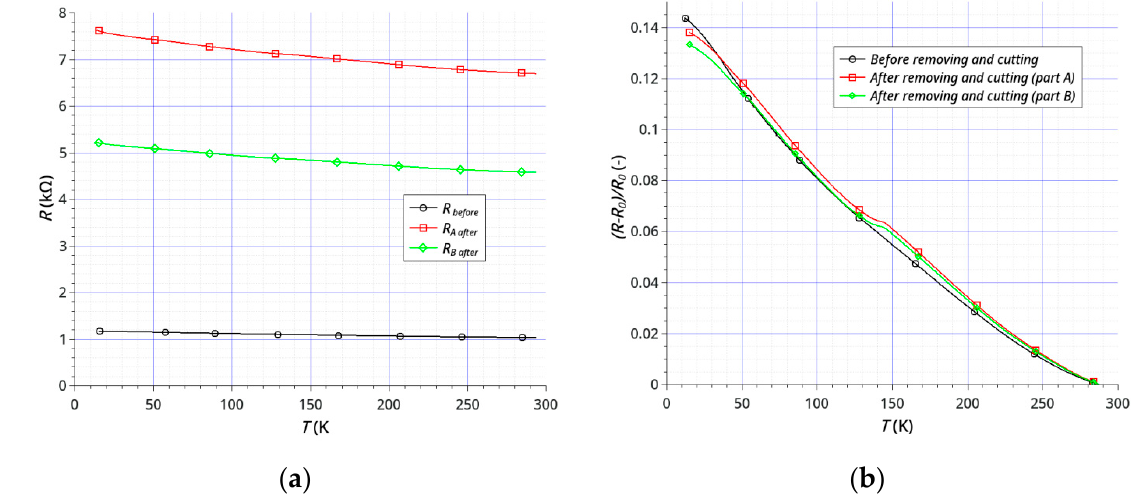
Figure 9. Temperature dependence of the resistance of the sample before and after laser cutting and reducing: ( a ) resistance R (k Ω ) of the sample and ( b ) relative changes in the sample resistance ( R 0 —initial resistance of the sample at T init = 293 K).